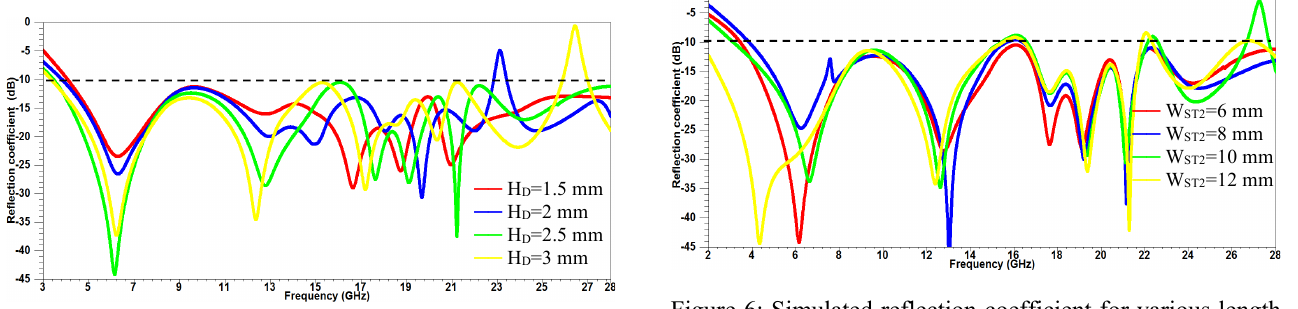
Figure 4: Simulated reflection coefficient for various height of DR.